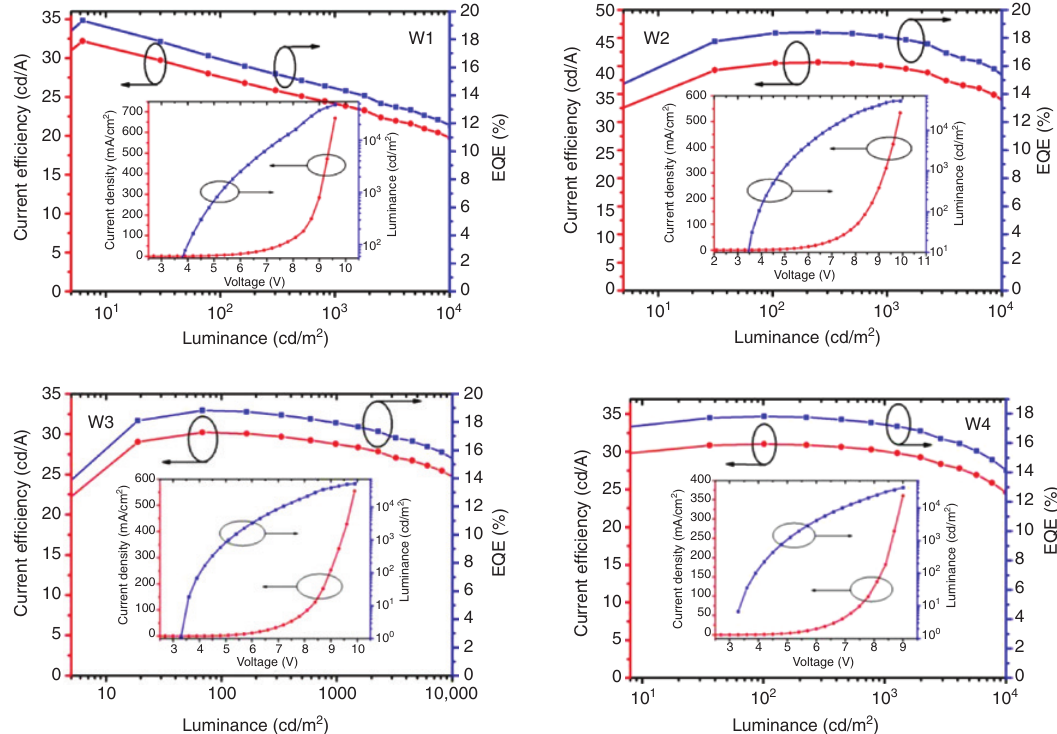
Figure 6: CE–L–EQE characteristic curves for four white devices, Inset: J-V-L characteristic curve for the corresponding white device.